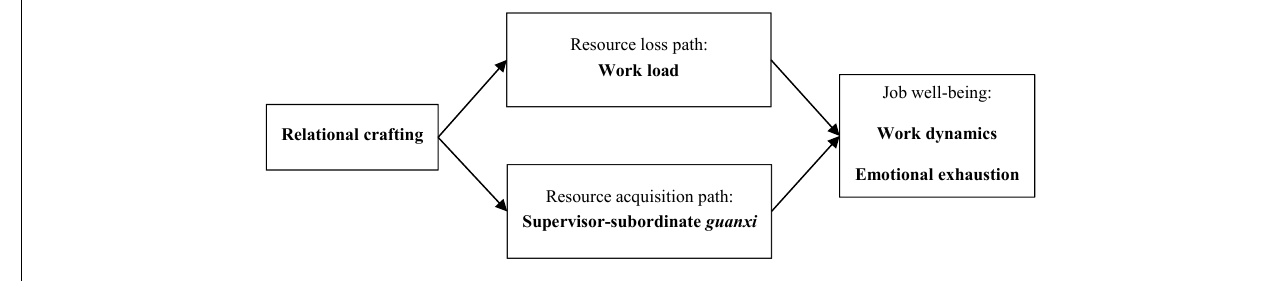
FIGURE 1 | Theoretical